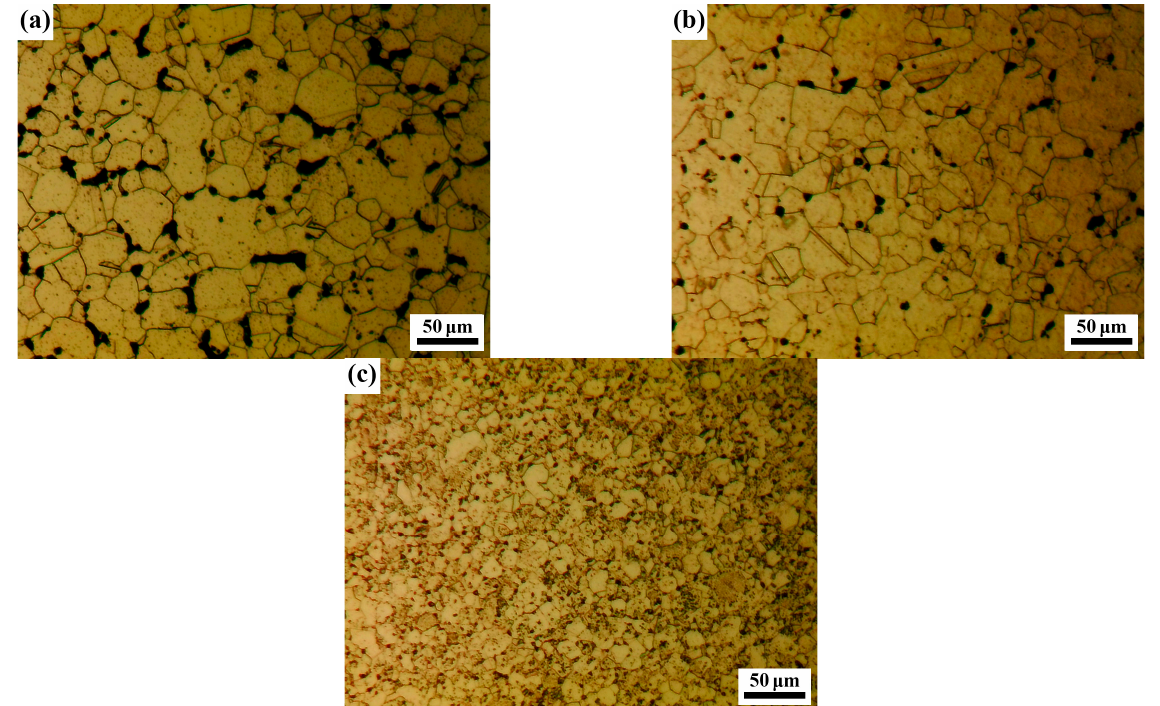
Figure 9. Microstructure of the FGH97 superalloy with different volumes of porosity after etching; ( a ) Ni1#, ( b ) Ni2#, and ( c ) Ni3#.